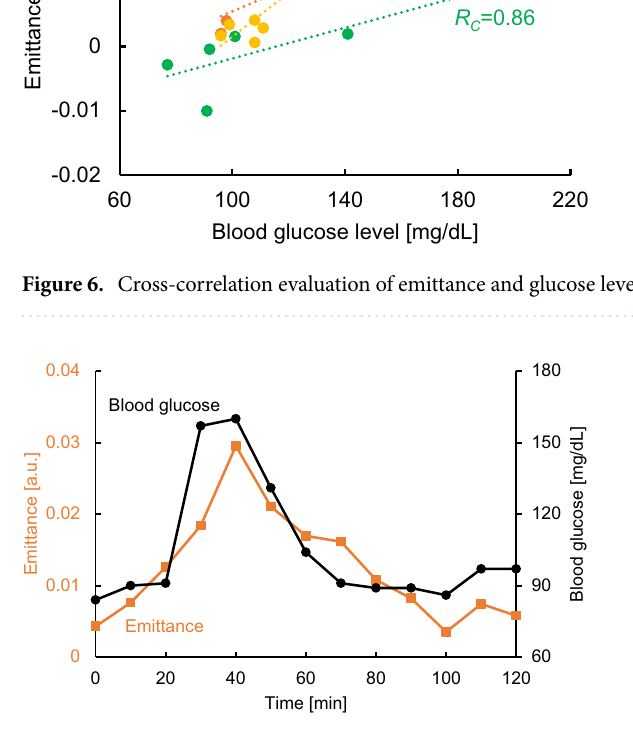
Figure 7. Time course of emittance and blood glucose levels during the additional experiment for subject